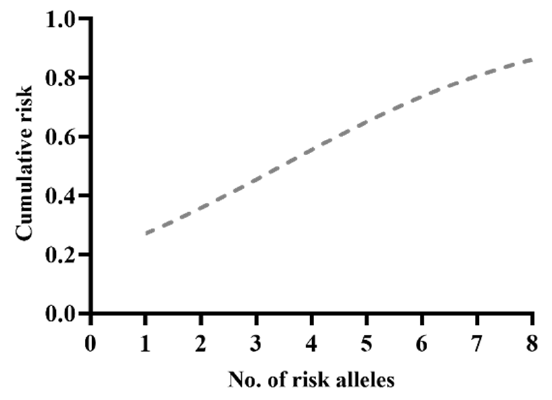
Figure 2. Risk alleles distribution within the PC group. The combined effect of the four selected SNPs was analyzed using a logistic regression model (Table 4). The analysis revealed a stronger cumulative association with PC ( p = 0.001). The cumulative OR associated with these four regions was 1.42-fold among those subjects who were carriers of at least one risk allele copy at each specific region, compared with subjects without any of these